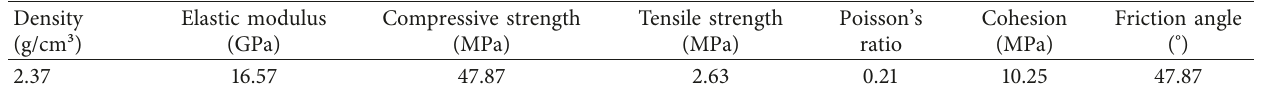
Figure 1: Geometry of hole and fissure in the sandstone specimens. is the fissure angle, a is the fissure length, and d is the hole diameter. In this study, the center hole and fissure in sandstone specimens were machined by high-pressure water-jet cutting. α Table 1: Basic mechanical properties of sandstone